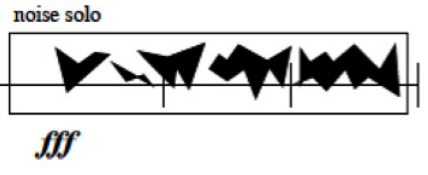
Figure 14. An example of timed duration of an event.